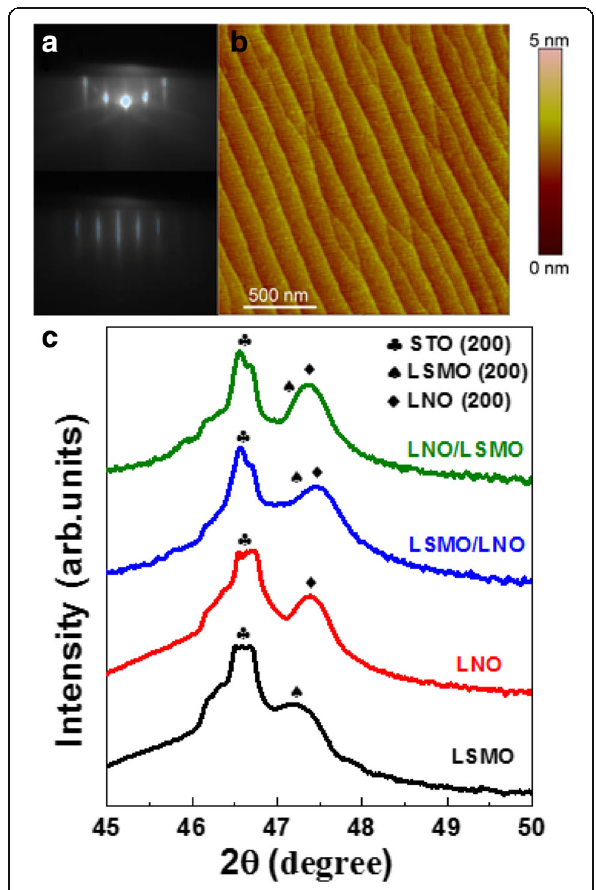
Fig. 1 a RHEED patterns of the STO substrate before and after the growth of the LSMO/LNO bilayer; b AFM topography image (2 × 2 μ m 2 ) of the STO substrate. The step height corresponds to one monolayer; c XRD spectra of all four types of samples grown on the STO